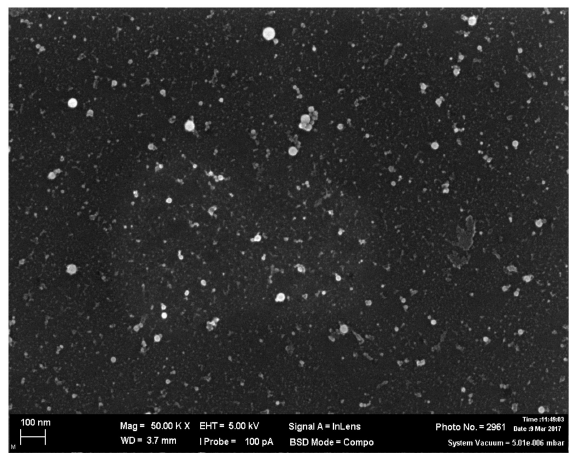
Figure 9. A SEM image of Al 2 O 3 particles at 50,000 × magnification.